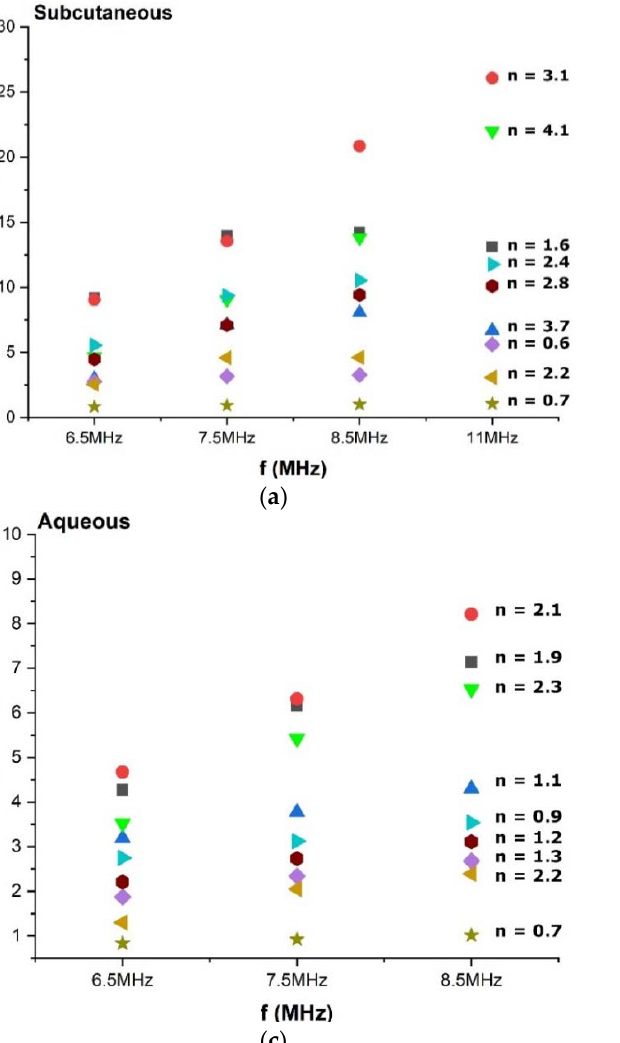
Figure 5. Attenuation versus frequency plot for three different environments, ( a ) Subcutaneous ( b ) Submuscular and ( c ) Aqueous. The attenuation coefficient dependence can be seen from the graphs above, α = α o f n